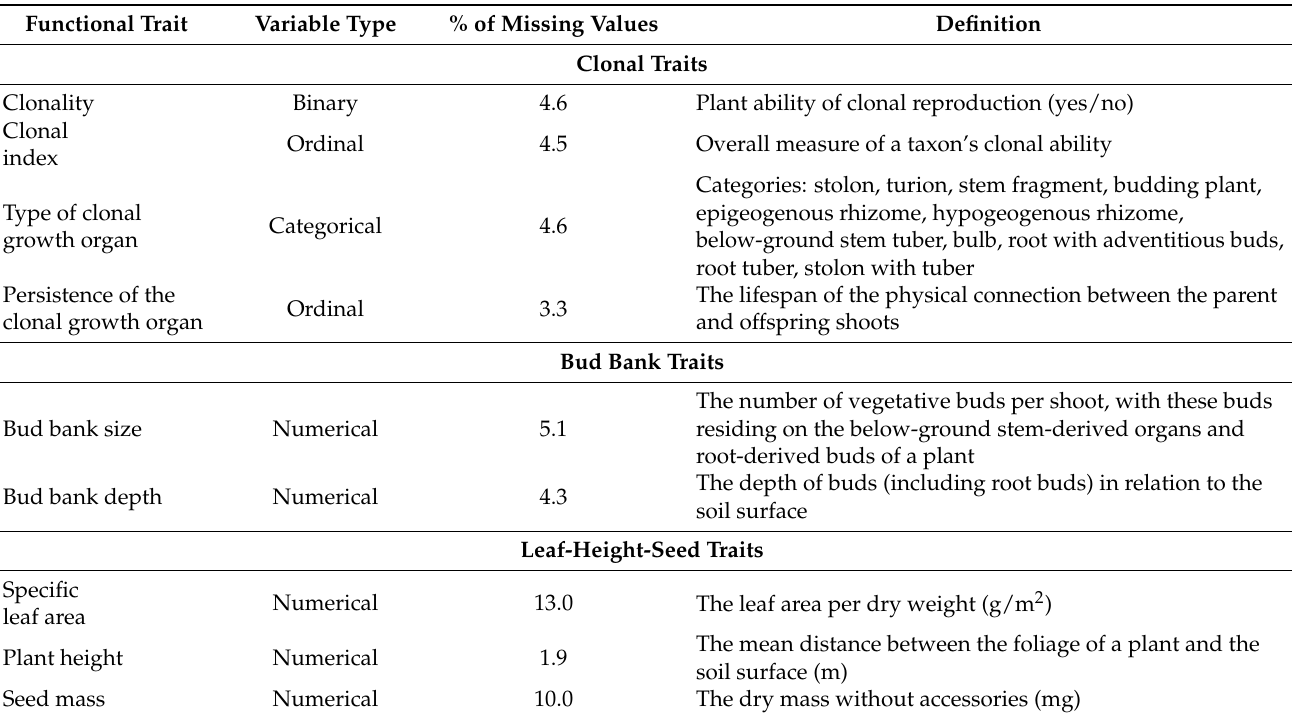
Table 2. Information on the three groups of plant functional traits used in this